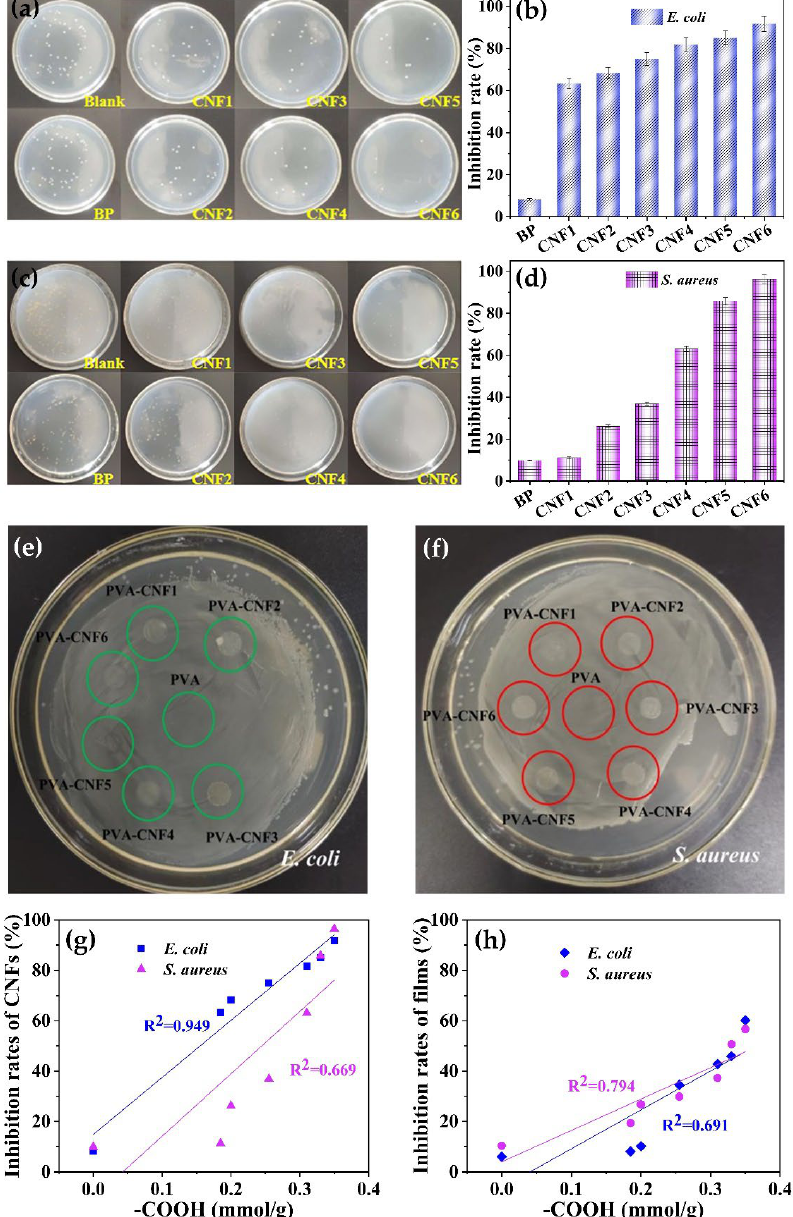
Figure 5. Inhibition of CNFs for E. coli ( a , b ) and S. aureus ( c , d ), inhibition of composite films for E. coli ( e ) and S. aureus ( f ), and the relationship between the carboxylic group content and the inhibition of CNF ( g ) and the composite films ( h ).